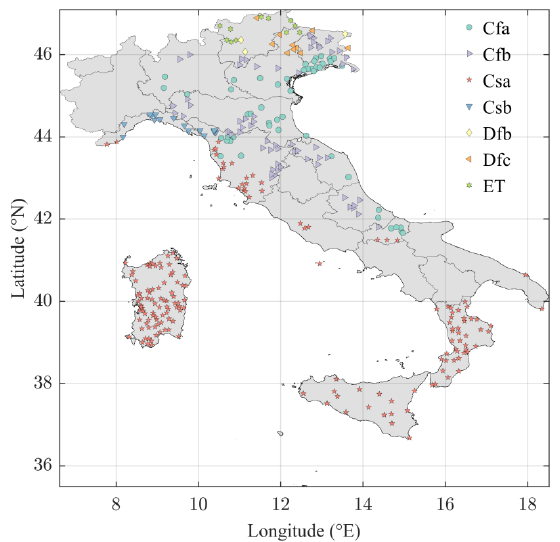
Figure 1. Location of the 332 stations selected from the SCIA dataset. Each station is depicted with a different marker based on the Köppen-Geiger (KG) classification [37,38]. Particularly, 53.8% of the stations belong to Csa-KG, 19.2% to Cfb-KG, 15% to Cfa-KG, 4.8% to Csb-KG, 3.3% to ET-KG, 3% to Dfc-KG, and 0.9% to Dfb-KG. All the information related to the stations are provided in Table S1 of the Supplementary Material.